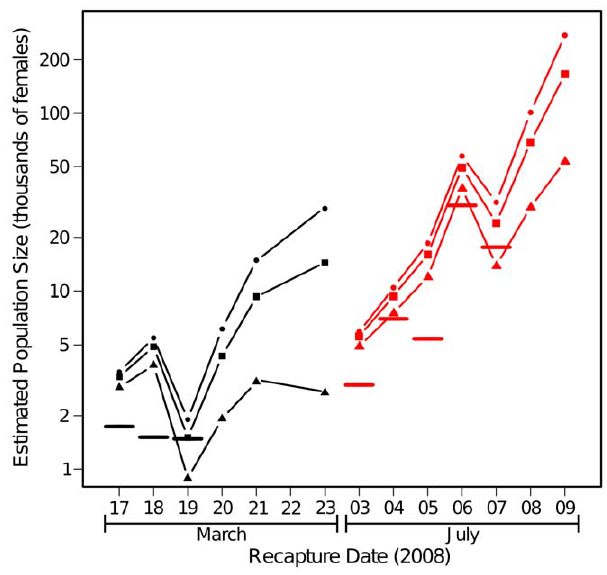
Figure 3. Lincoln index and Fisher-Ford estimates of popula- tion size in Fourda over time with varying survivorship. Lincoln index estimates (horizontal lines) are based on recaptures of marked mosquitoes released the previous day only. Fisher-Ford estimates per day are based on recaptures on all days prior to the estimate with an assumed daily survival rate ( s ): Triangles, s =0.6; Squares, s =0.8; Circles, s =0.9. Black symbols and lines, dry season; Red symbols and lines, wet season.